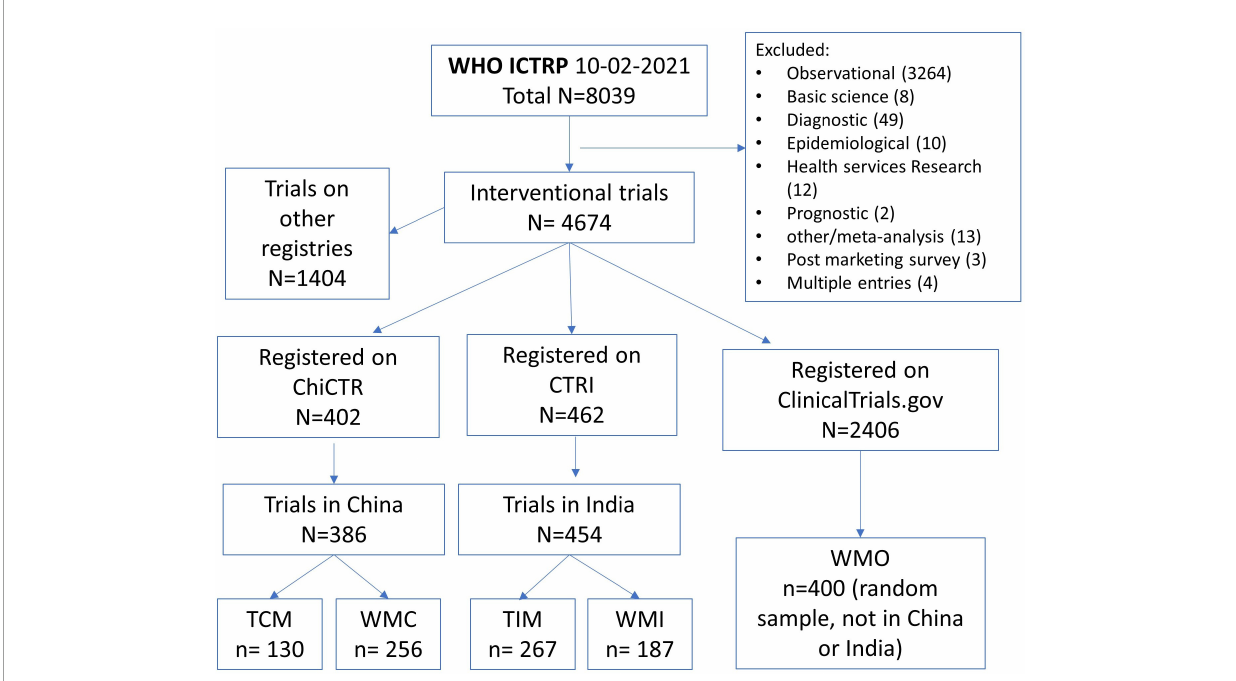
FIGURE1 Process of selecting registered COVID-19 interventional trials. ChiCTR, Chinese Clinical trial Registry; CTRI, Clinical Trials Registry-India; TCM, traditional Chinese medicine; WMC, trials on conventional (western) medicine in China; TIM, traditional Indian medicine; WMI, trials on conventional medicine in India; WMO, conventional or other medicine in countries other than China and